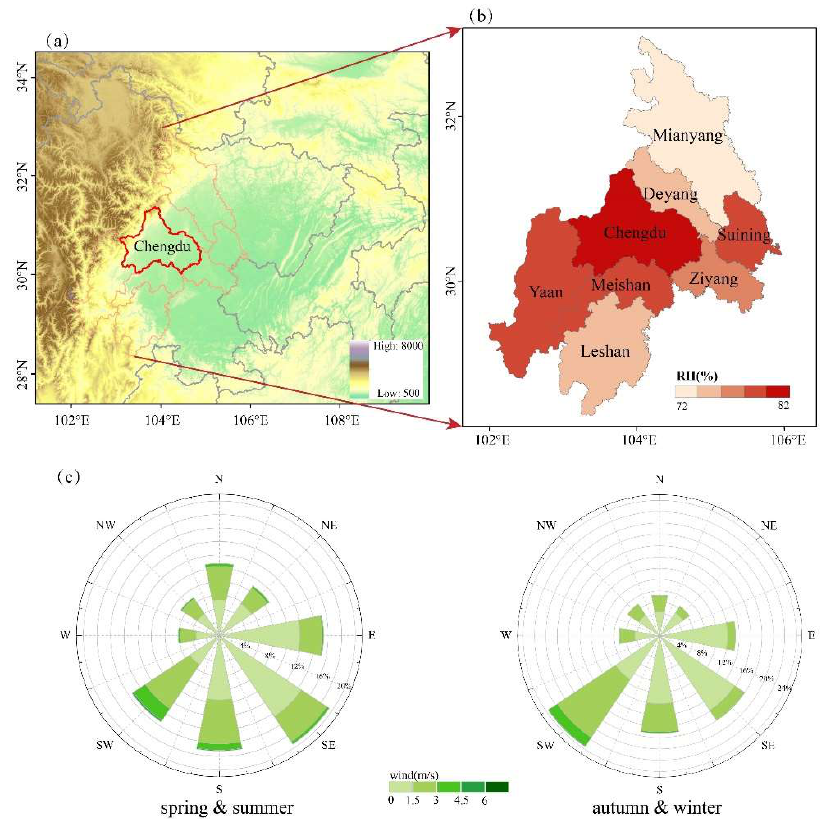
Figure 1. Distributions of ( a ) topography, ( b ) relative humidity distribution and ( c ) wind rose map of the study area.